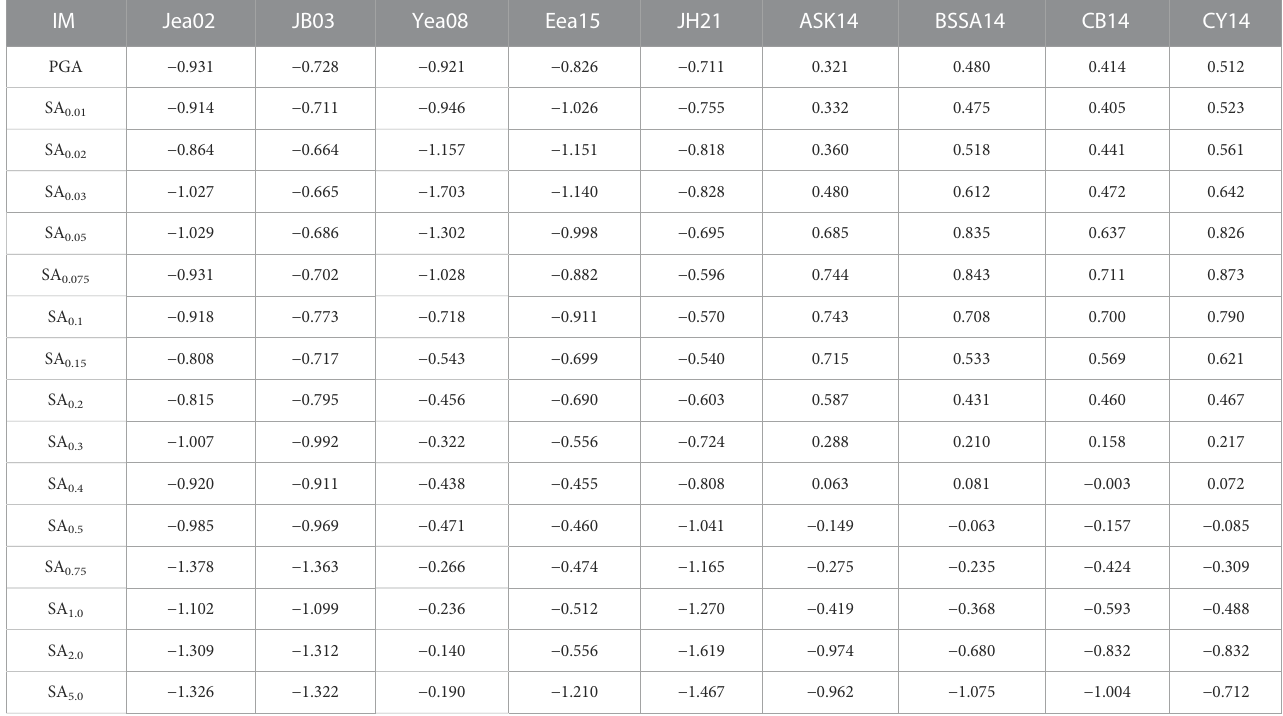
TABLE 3 Global bias of the mixed-effect linear regression for fi ve local and four global GMMs.